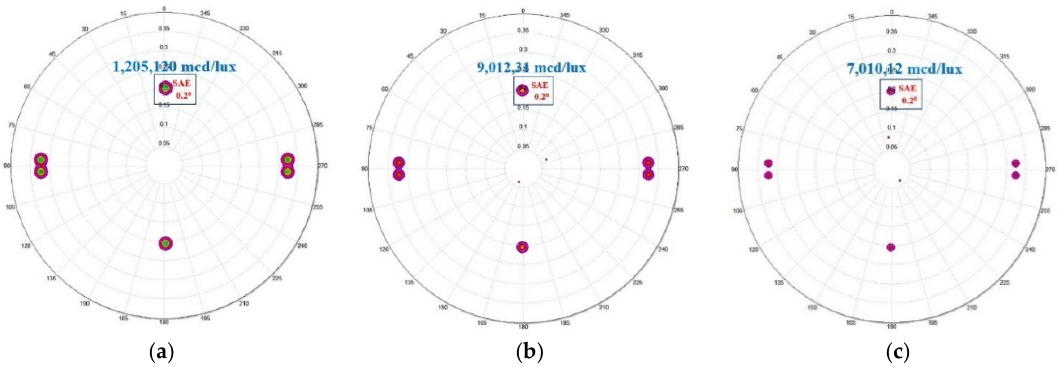
Figure 16. The R I and intensity distributions on anterior, central, and posterior regions, which are shown in: ( a – c ) Optimized SAE SuperPin Plus curved CCR.